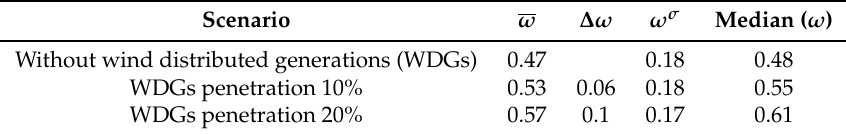
Table 9. Battery cycle usage results for various wind penetration levels.